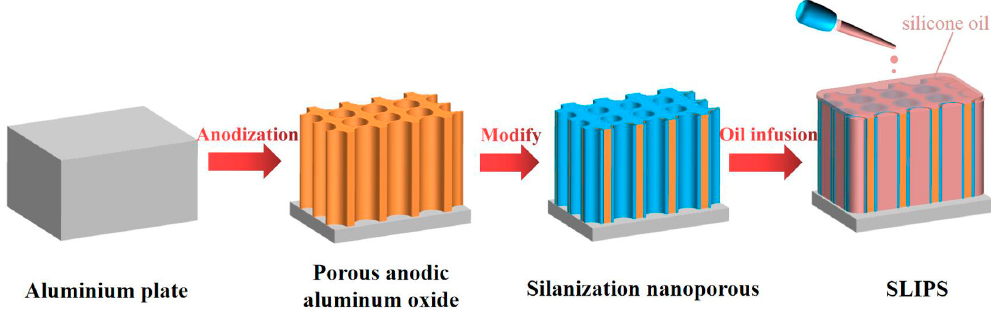
Figure 1. Process diagram for the fabrication of slippery lubricant-infused porous surfaces (SLIPSs).